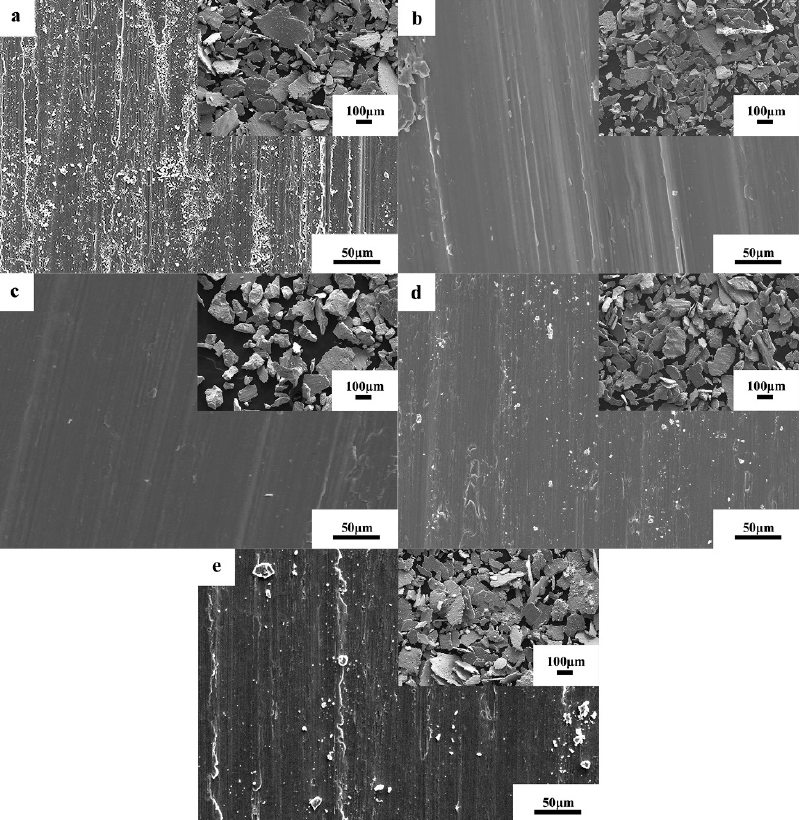
Figure 10. Surface morphology of coatings after dry-sliding wear test ( a ) substrate, ( b ) 10ZrN, ( c ) 20ZrN, ( d ) 30ZrN, and ( e ) 40ZrN.